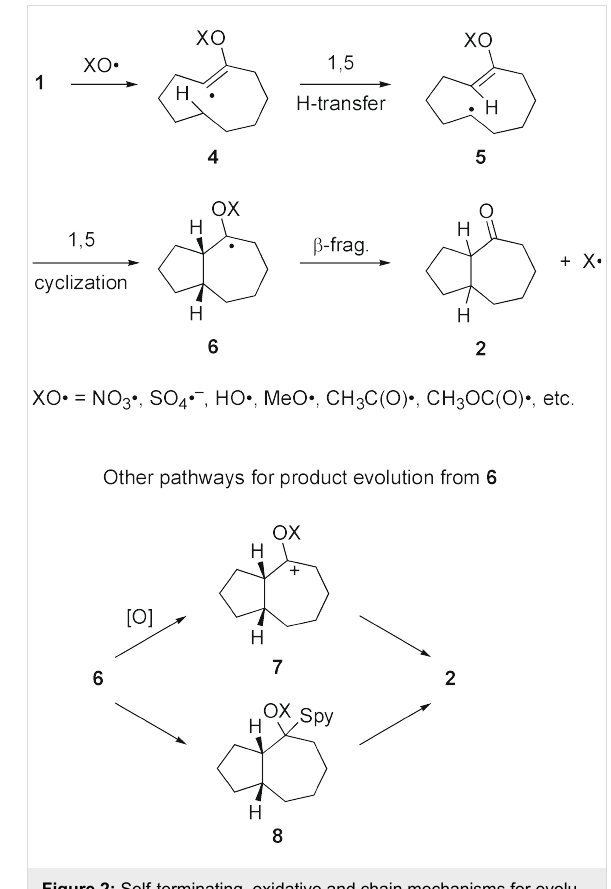
Figure 2: Self-terminating, oxidative and chain mechanisms for evolu- tion of 6 to 2